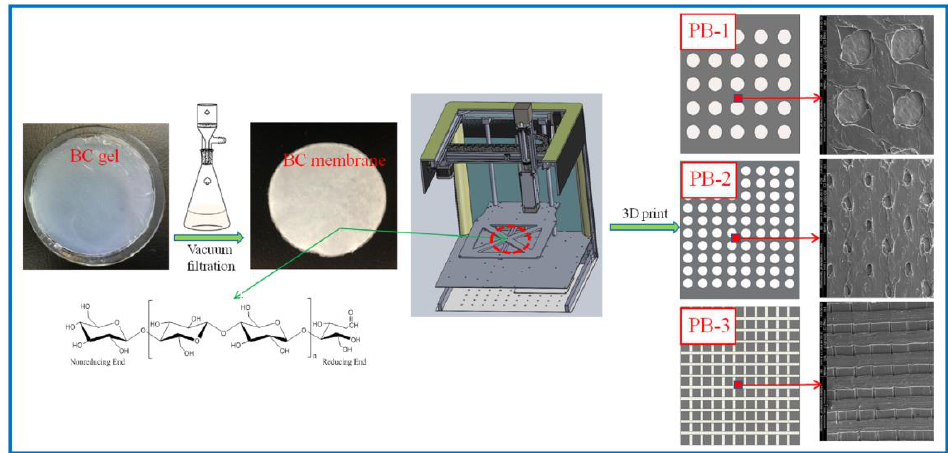
Figure 1. Schematic diagram of the preparation process of PLA/BC composite